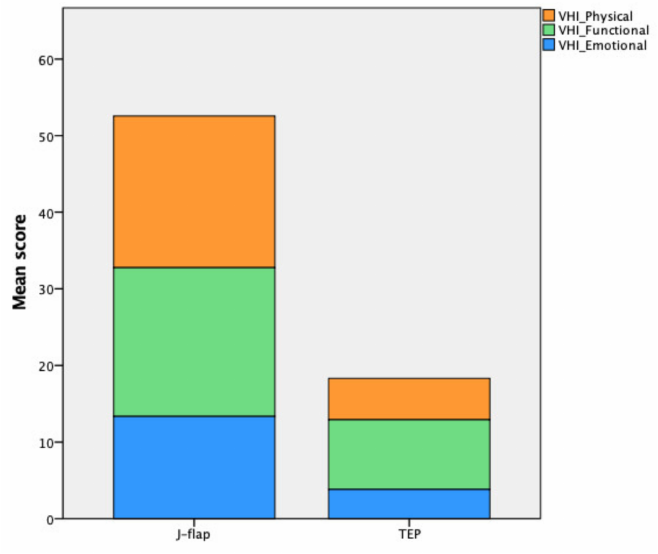
Figure 4. Voice handicap index